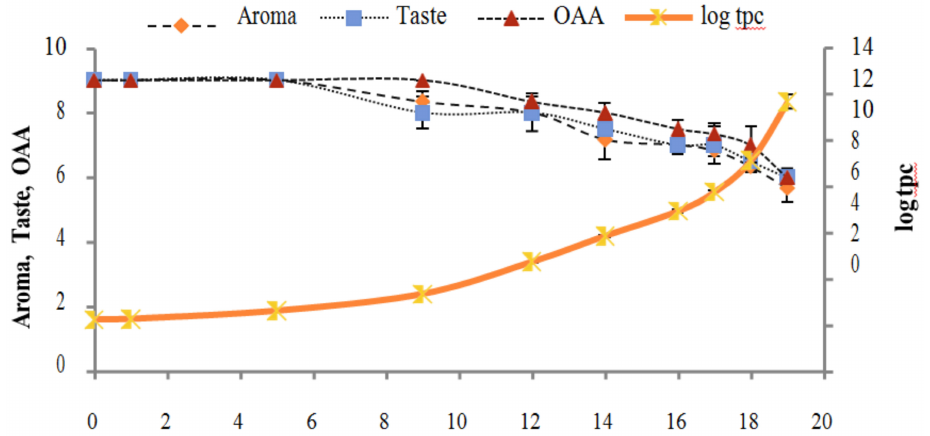
Figure 8. Relationship of total psychrotrophs count log cfu/mL growth trends with sensory scores of pasteurized milk for spoilage detection stored at 4 ◦